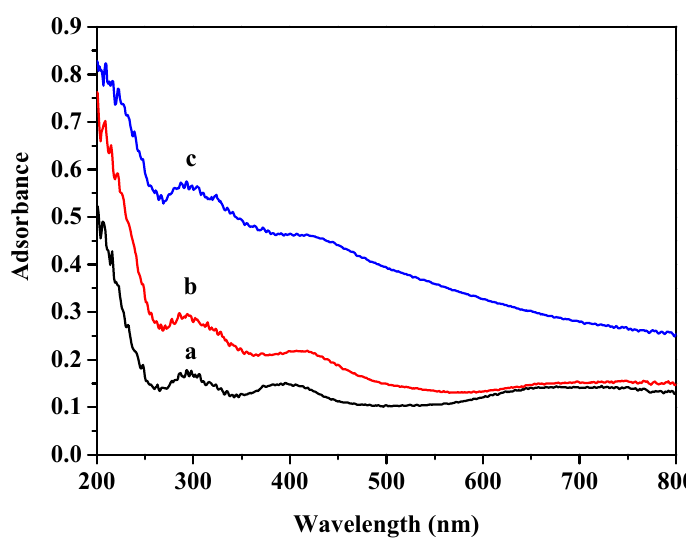
Figure 10. UV-Vis spectrum of Ni / Si-Al (7.7, RT) activated at ( a ) room temperature, ( b ) 200 ◦ C and ( c ) 400 ◦ C,